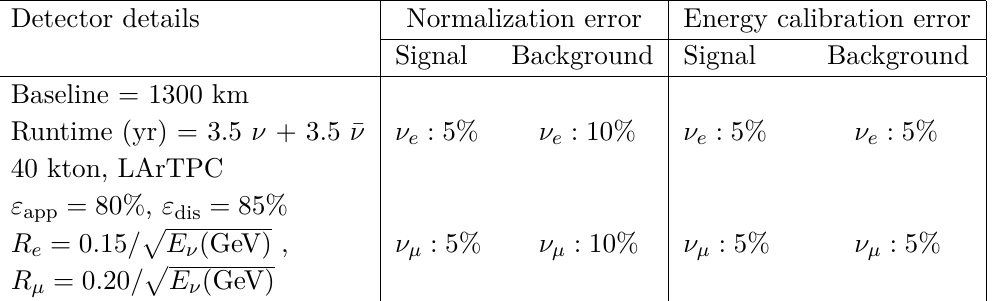
Table 2 . Details of detector configurations, efficiencies, resolutions, and systematic uncertainties for DUNE. Here, ε R µ are energy resolutions for ν CC 1 . 47 × 10 21 POT (protons on